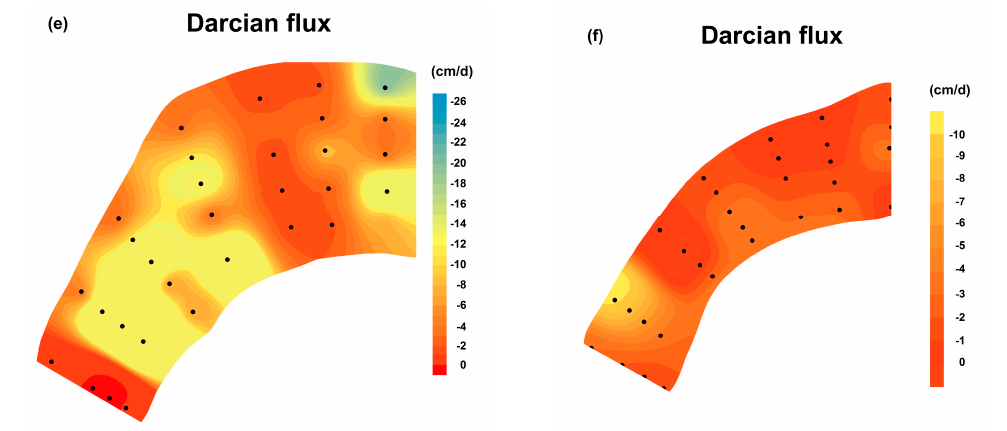
Figure 4. Interpolated contour plots of K v ( a , b ), VHG ( c , d ), and Darcian flux ( e , f ) in July 2015 (the left plots) and January 2016 (the right plots). (The length of sediments columns has been showed at each test point in plot ( a , b ); upward and downward arrows in plot ( c , d ) represent upwelling and downwelling, repectively).